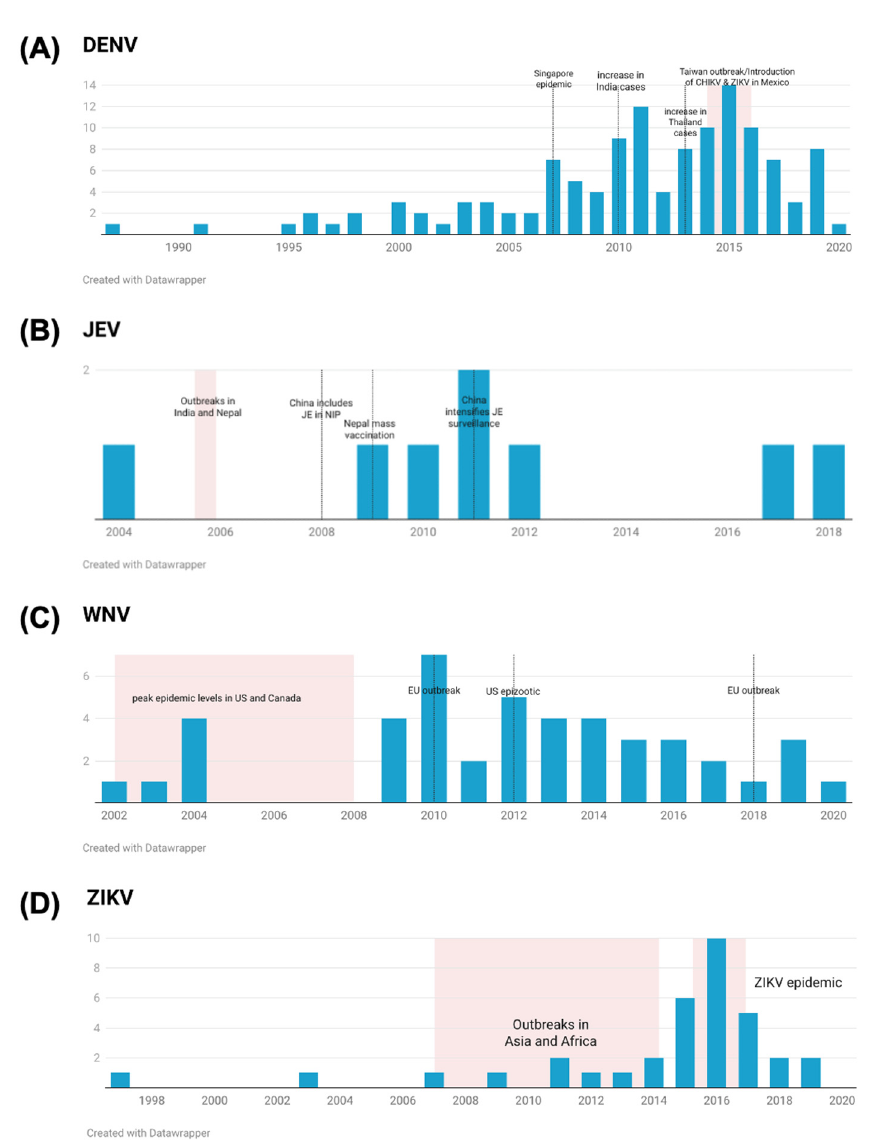
Figure 5. Trends in flavivirus seroprevalence studies over time: ( A ) DENV, ( B ) JEV, ( C ) WNV, ( D ) ZIKV.